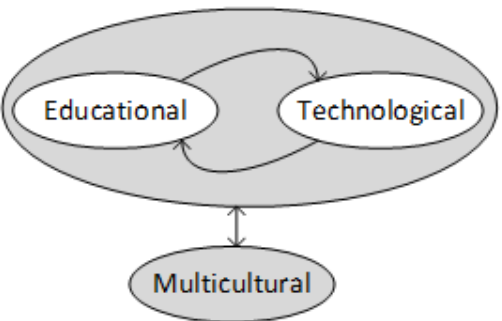
Figure 1. Engineering teaching/education